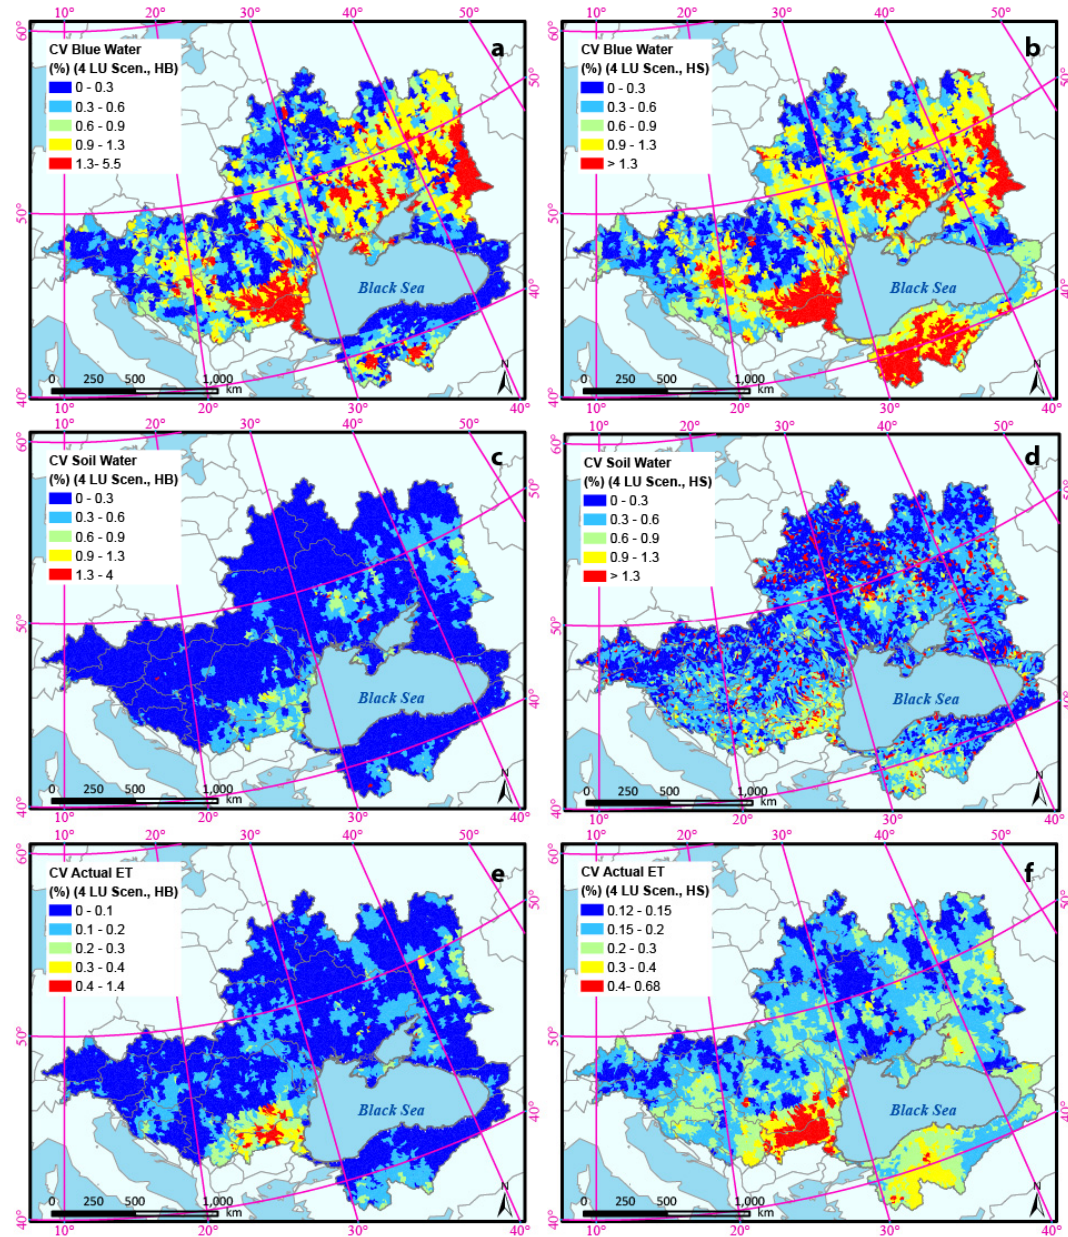
Figure 10. Coefficient of variation (CV) of the model predictions using four future landuse scenarios (BS ALONE, BS COOL, BS COOP, and BS HOT) in combination with the HB future climate Scenario ( left column ) and the HS future climate scenario ( right column ). ( a , b ) blue water resources; ( c , d ) green water storage (soil moisture); ( e , f ) green water flow (evapotranspiration). LU, landuse.